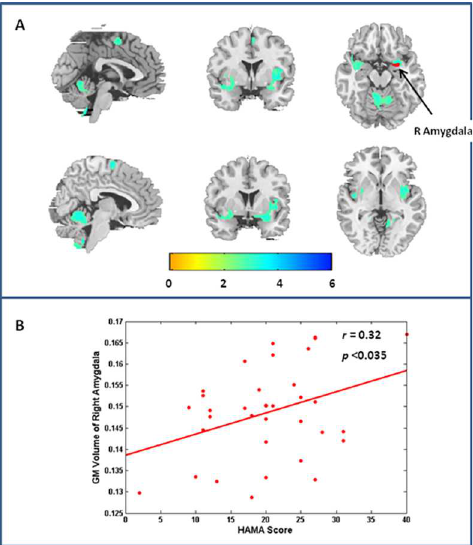
Fig 1. Regions showing significantly altered GM volume in females with MDD compared to HC. Panel A shows the regions representingsignificantly decreasedGM volume in females with MDD comparedto HC, including bilateral insula,bilateralamygdala,right hippocampus, bilateral parahippocampus gyrus, bilateral putamen, bilaterallingualgyrus, cerebellum, and caudal middlefrontal regions. In contrast, no significant increasein GM volume was detected among females with MDD comparedto HC. The significance level was set as single voxel threshold of p < 0.005and cluster size > 396 voxels, using AlphaSimcorrection. Panel B shows the right amygdala,with structural deficits, exhibits a significantcorrelationbetweenGM volume and anxiety scores in females with MDD (r = 0.32, p = 0.035).